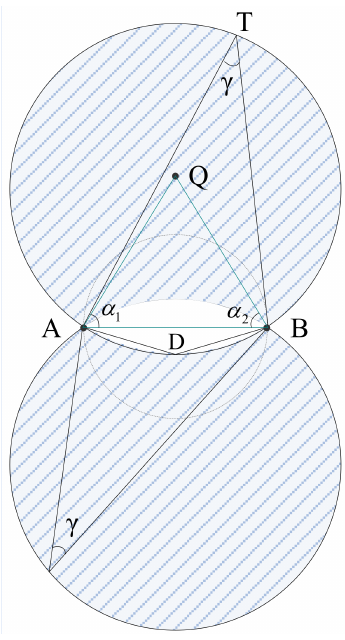
Figure 2. Range of direction